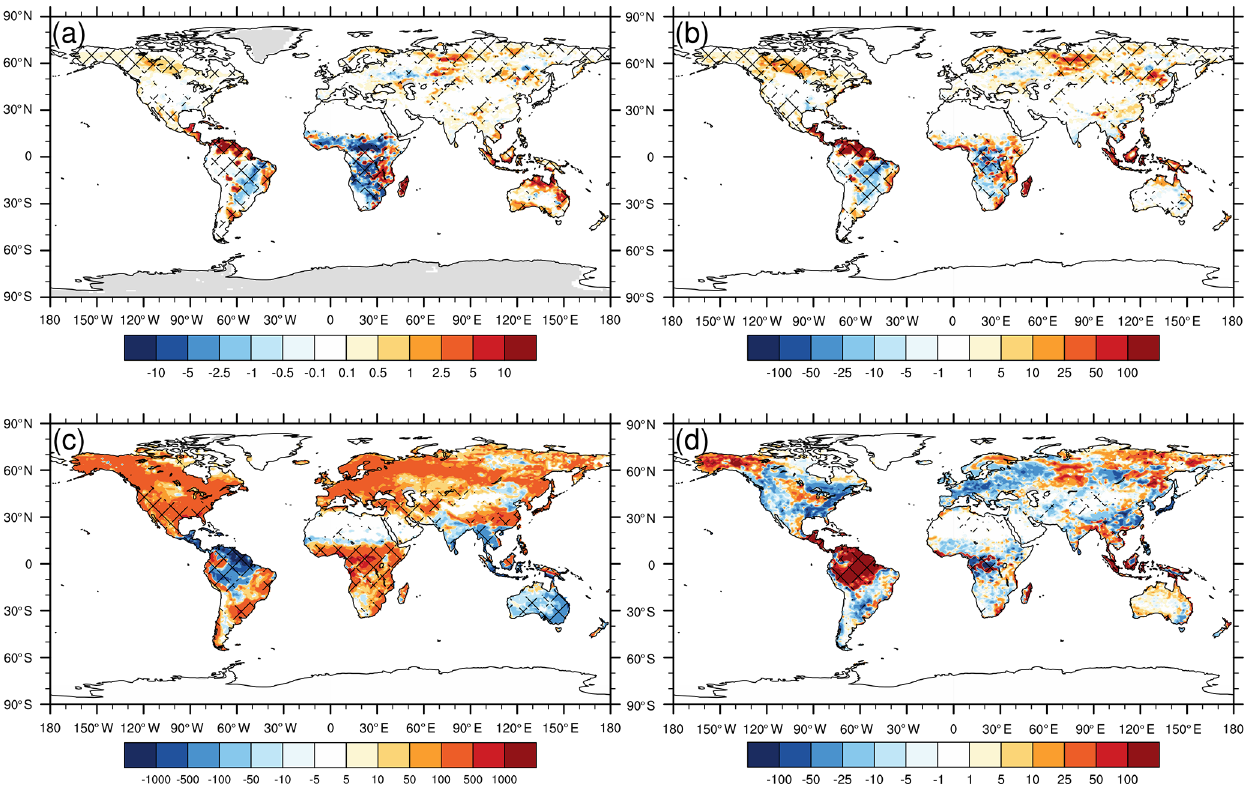
Figure 7. CESM-RESFire-simulated changes between the RCP4.5 future scenario and the present-day scenario (CTRL2–CTRL1) in (a) an- nual fractional burned area (%yr − 1 ), (b) annual averaged fire carbon emissions (gCm − 2 yr − 1 ), (c) annual averaged GPP (gCm − 2 yr − 1 ), and (d) annual averaged NEE (gCm − 2 yr − 1 ). The hatching denotes the 0.05 significance